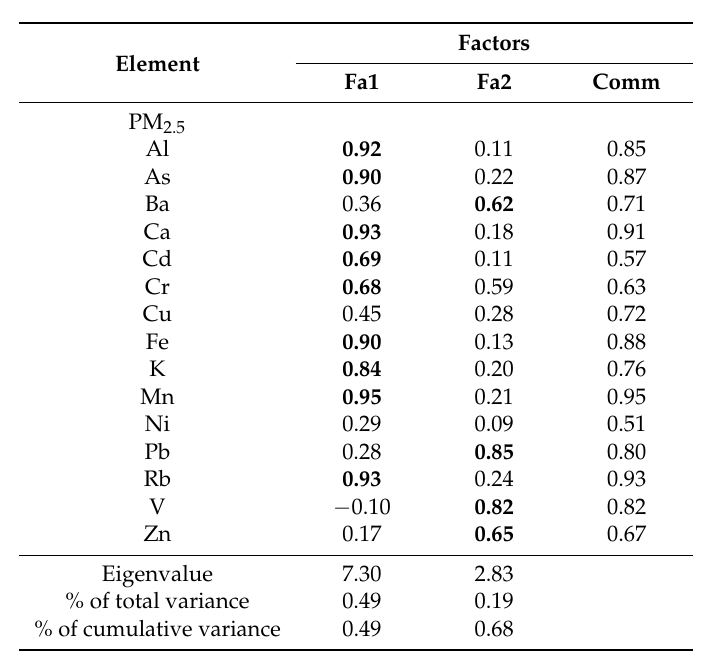
Table 5. Factor (Fa) loadings of the two extracted factors (principal component analysis, varimax standardized rotation) for PM 2.5 samples (element concentration of 24-h samples in µ g/m 3 ), together with the respective communalities (comm). Loadings superior to 0.60 (in bold) are considered as significant.